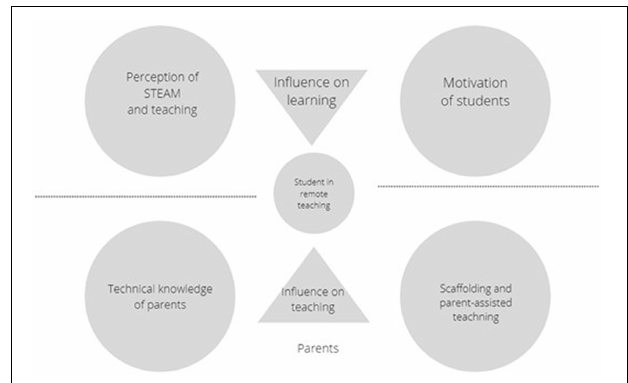
FIGURE 3 | Framework on learning in remote teaching with parent-assisted